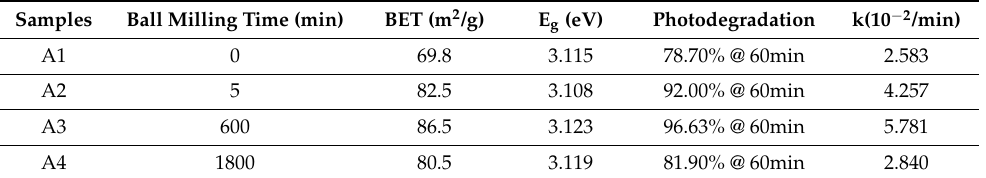
Figure 4. BET analysis of each product. Table 5. Specific surface area, bandgap width, and photocatalytic degradation efficiency, and the reaction-level kinetic constants for each